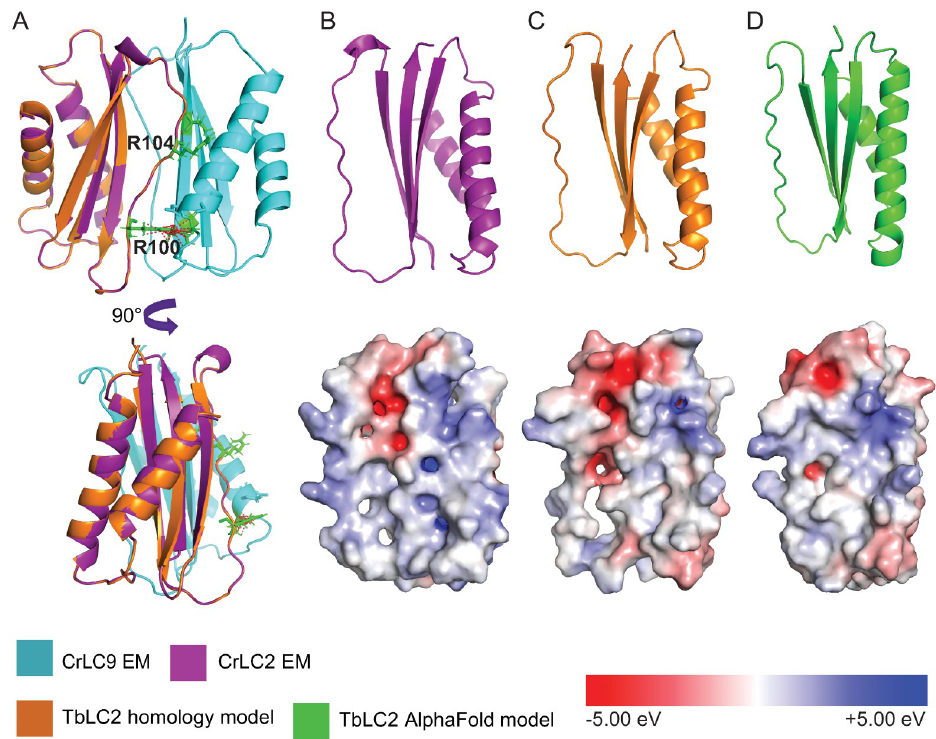
Fig 1. TbLC2 shows a high degree of structural and electrical potential conservation with the C . reinhardtii LC2 protein. A . Alignment of the sequence-based structural homology model of TbLC2 ( orange ) with LC2 and LC9 (denoted as CrLC2, purple , and CrLC9, cyan , respectively) from the C . reinhardtii outer dynein arm core subcomplex structure (PDB ID: 7KZN [26]). R100 and R104 ( green ) in CrLC2, which are highly conserved polar residues, have extensive contacts ( red dotted line ) with CrLC9. The structures ( top ) of CrLC2 in B ., the structural homology model of TbLC2 in C ., and the template-free model of TbLC2 in D ., are shown with surface charge density mapped to the electrostatic potential distribution ( bottom ). The homology model of TbLC2 in panels A and C ( orange ) was generated by SWISS MODEL and used and modified under the creative commons license CC BY-SA 4.0.